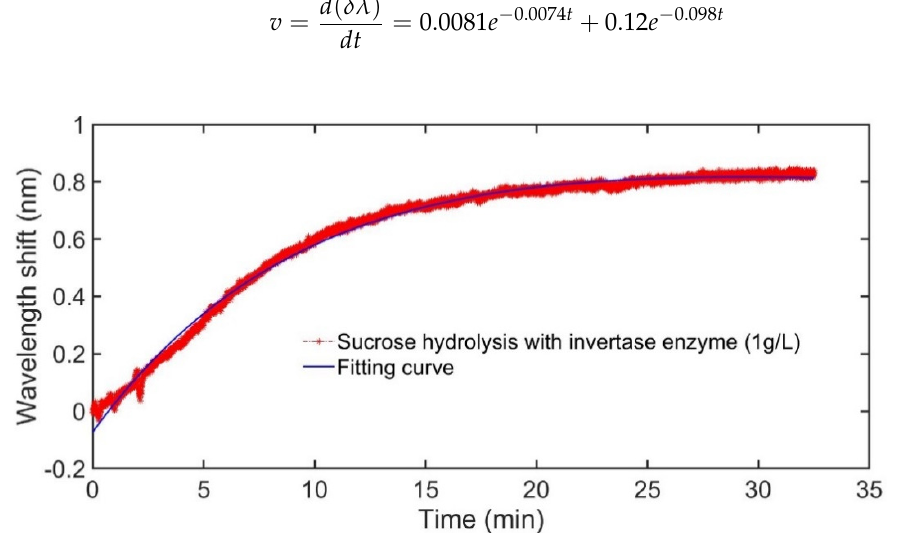
Figure 9. The numerical fitting of experimental data.